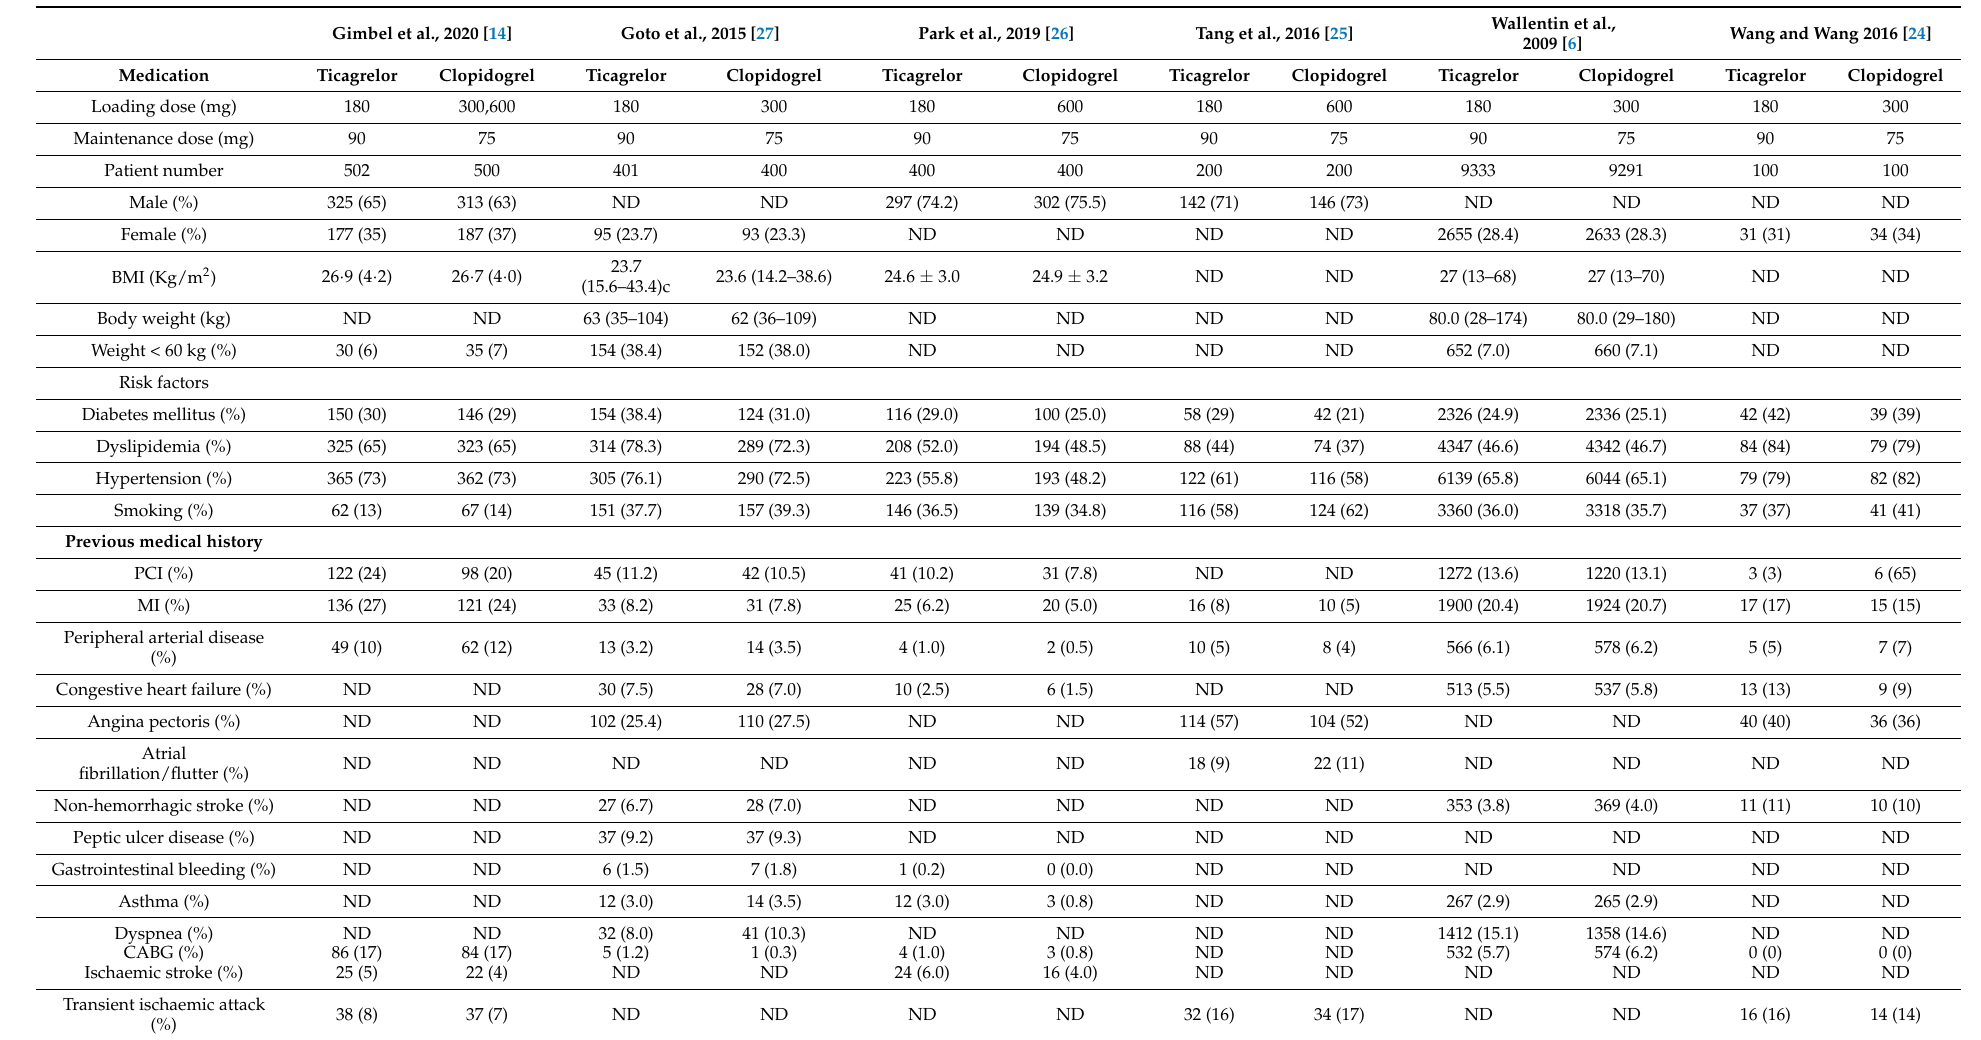
Table 2. Baseline characteristics of patients in each